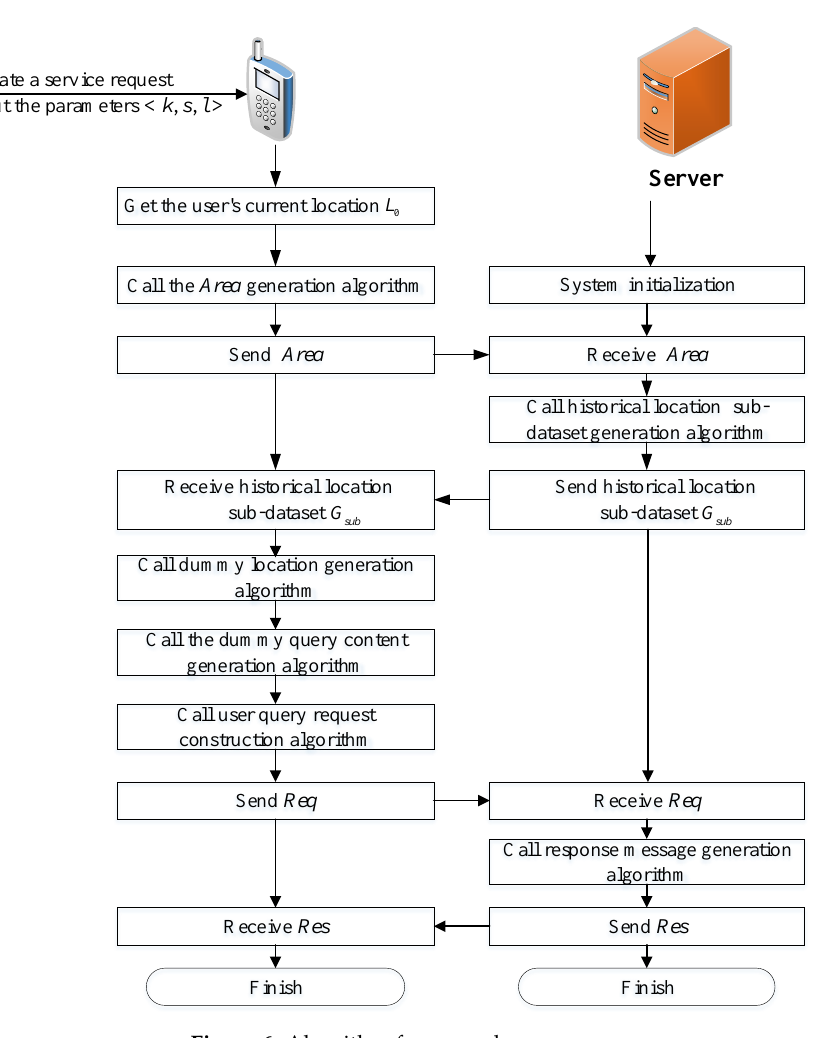
Figure 6. Algorithm